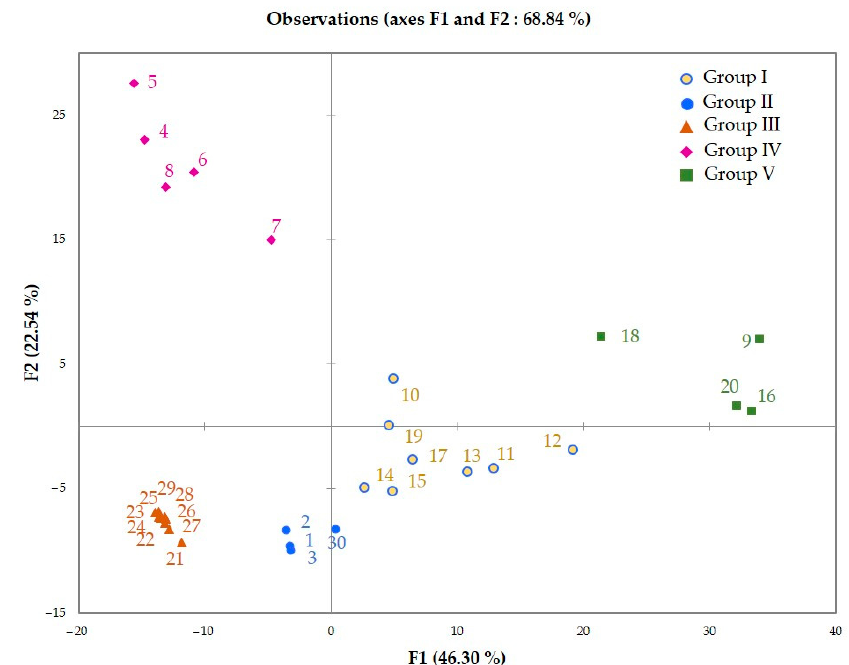
Figure 3. Principal component analysis (PCA) of the 30 leaf EO samples from N. acuminata .